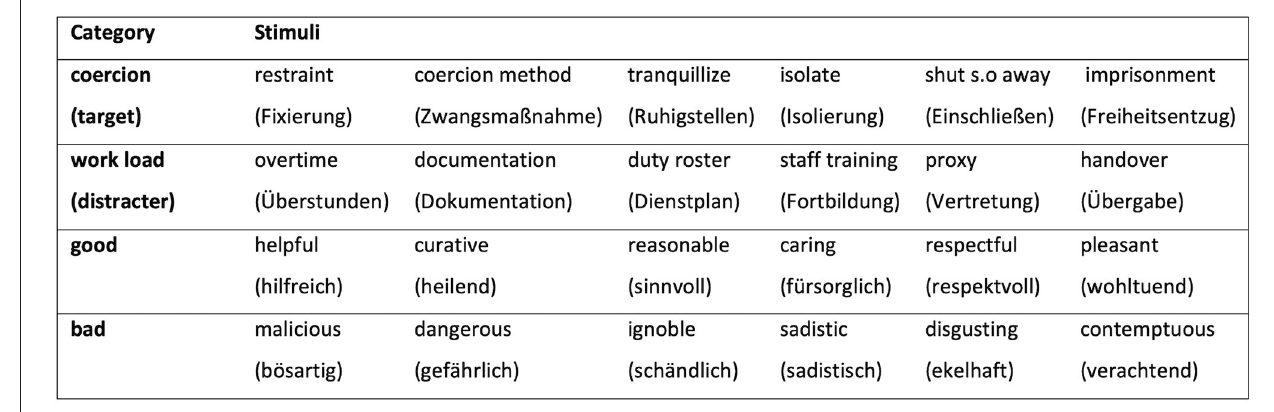
FIGURE 3 | Categories and stimuli used in the GNAT.